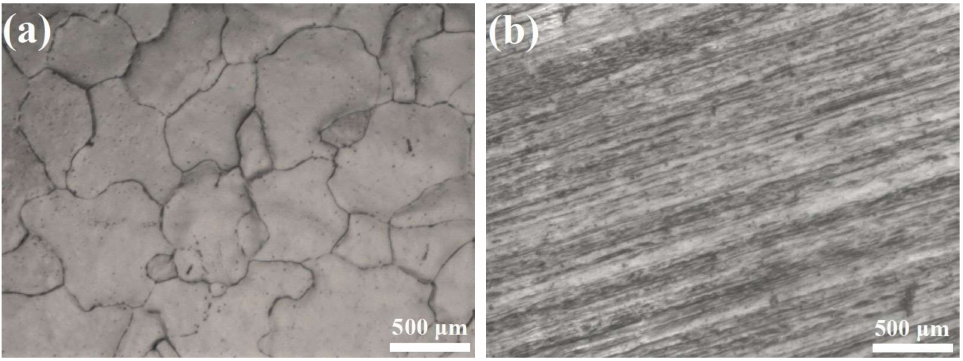
Figure 2. Optical microstructure of the ( a ) cast and ( b ) ECAPed